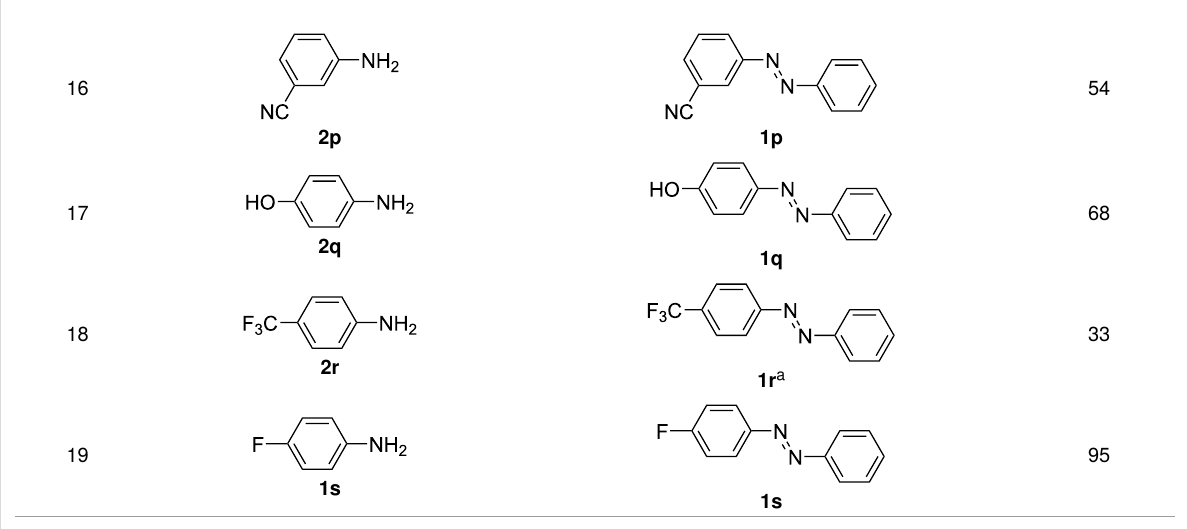
Table 1: Substrate scope of the Baeyer–Mills reaction under the optimized conditions in continuous flow.